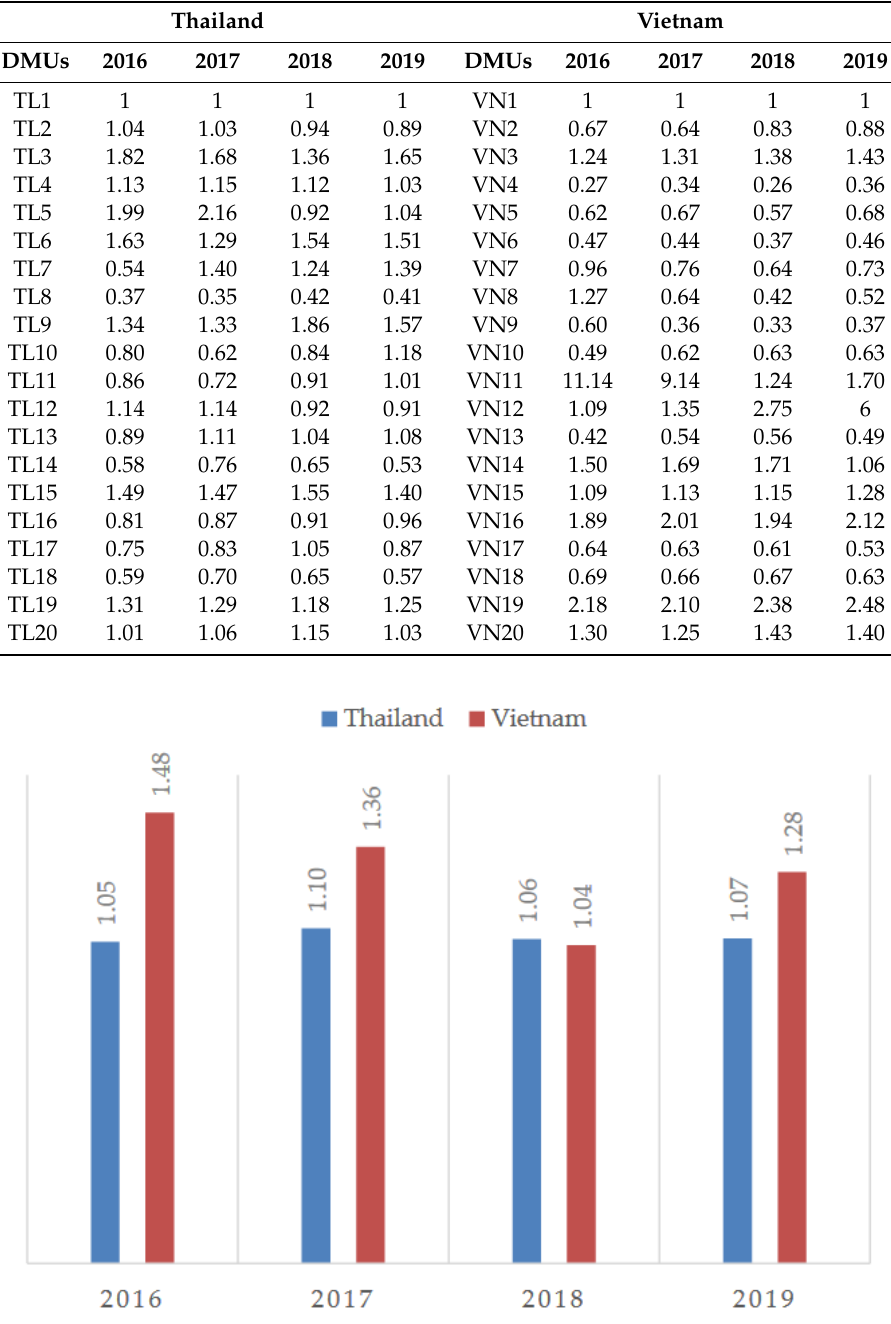
Table 4. Super slacks-based measure SBM score (2016–2019).